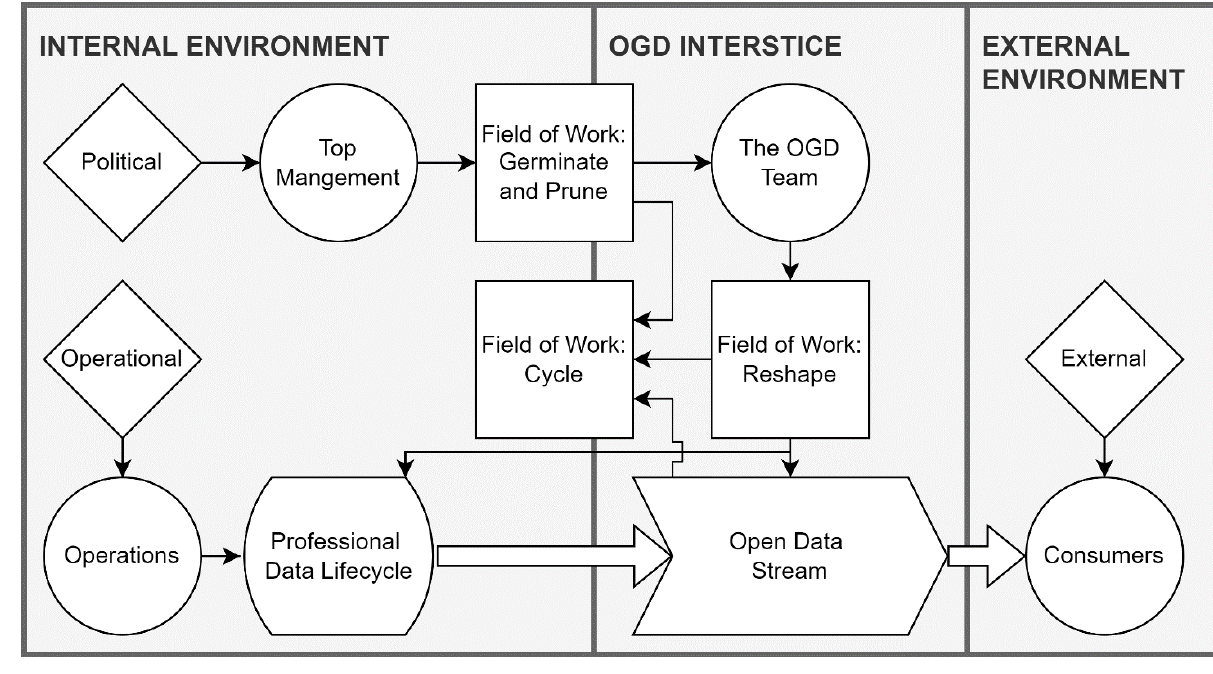
Figure 2: Overview of the publisher